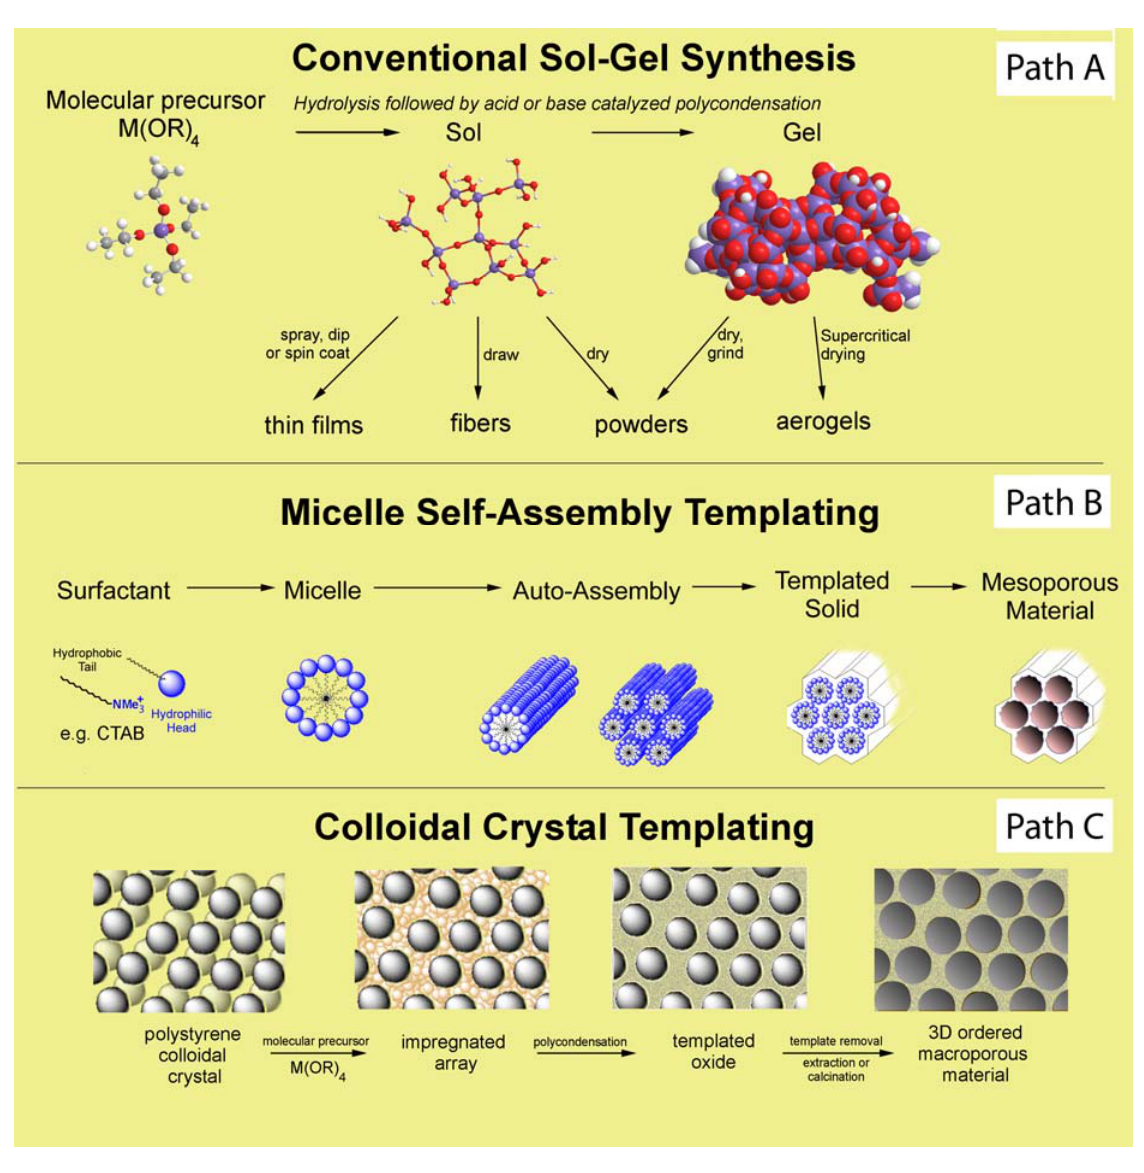
Figure 1. Common pathways to porous inorganic materials: (a) Conventional sol-gel route (b) Micelle self-assembly templating (c) Colloidal crystal